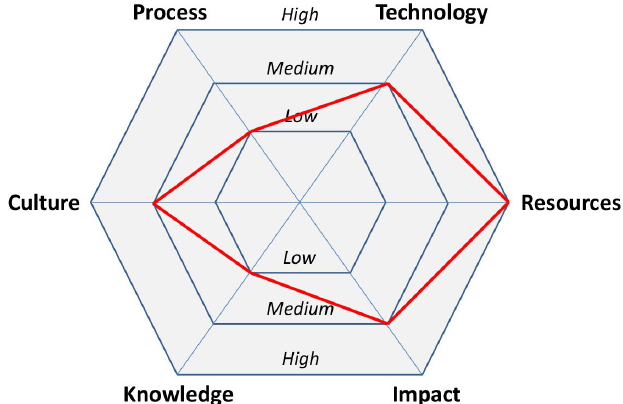
Figure 5. Application of health check tool to project from case study